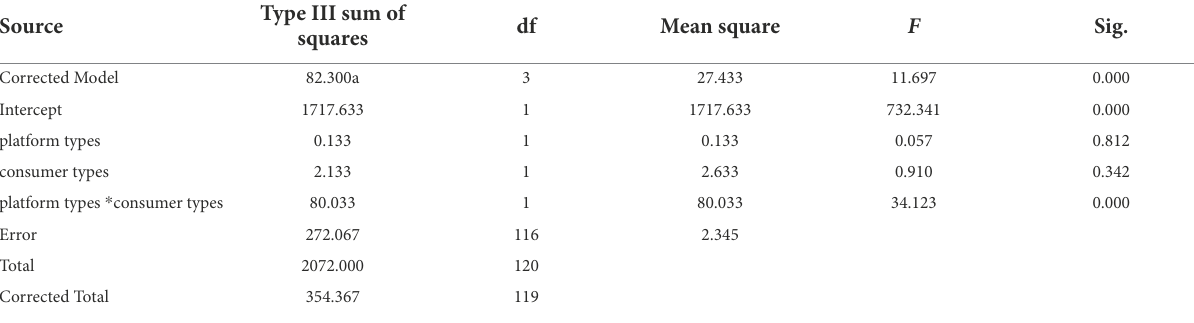
TABLE 1 The impact of the interaction between platform type and consumer type on purchase